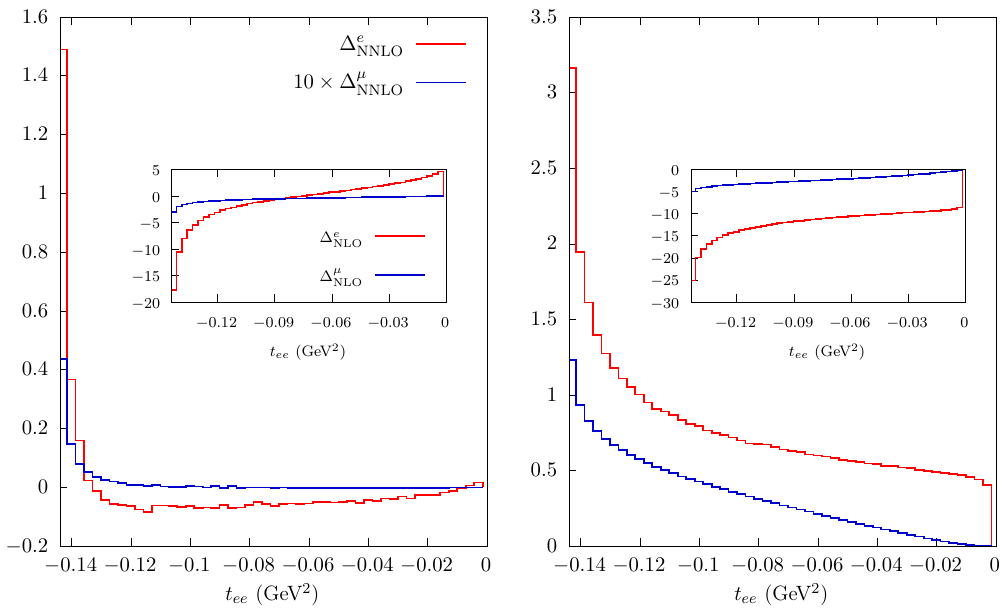
Figure 7 . The same as (cid:12)gure 3 for the squared momentum transfer measured along the electron line, t ee